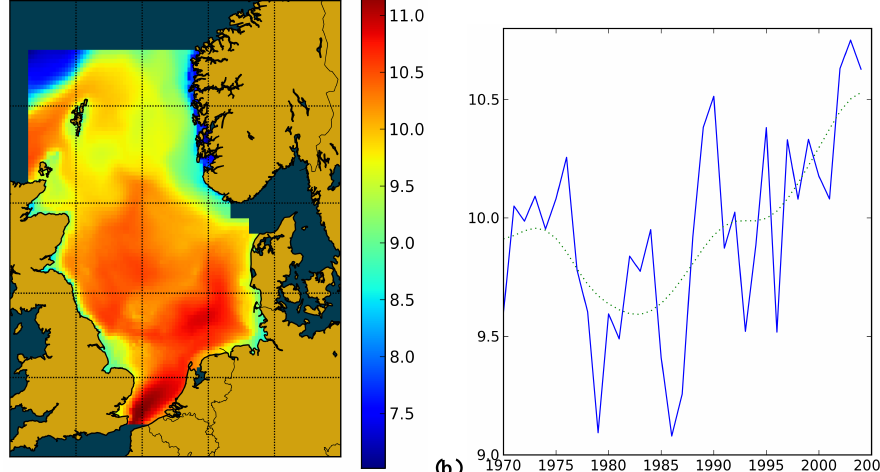
Fig. 3. (a) Temporally averaged temperature ( ◦ C), 1970–2004, from POLCOMS, averaged over depth. (b) Spatially averaged temperature ( ◦ C), 1970–2004, from